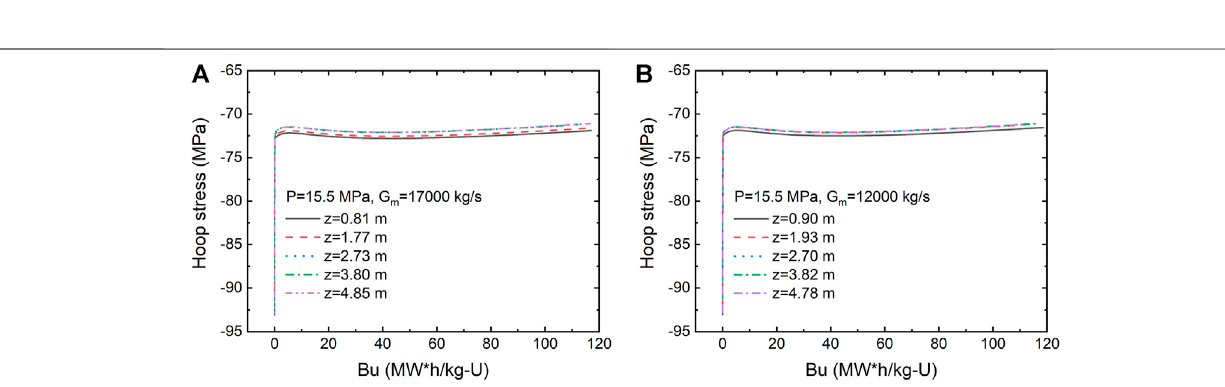
Frontiers in Energy Research |